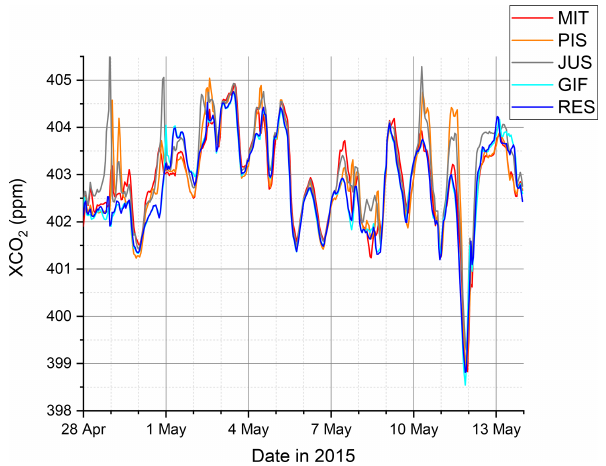
Figure 5. Modelled XCO 2 for all stations.